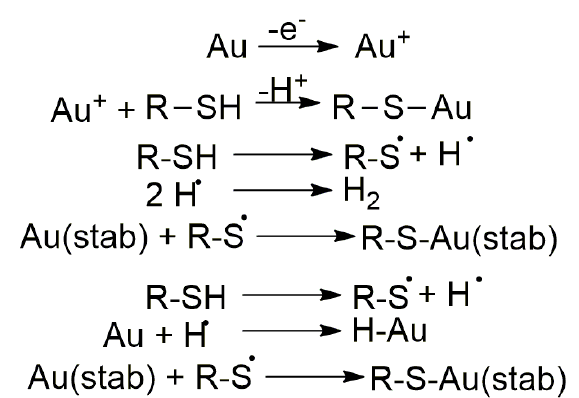
Figure 7 - Pathways proposed to thiol adsorption 6.1 by (Ron and Rubinstein 1998)measurement of the current corresponding to ethanol oxidation at the applied potential provides a convenient means for real-time monitoring of the self-assembly (SA and 6.2 (Tielens and Santos